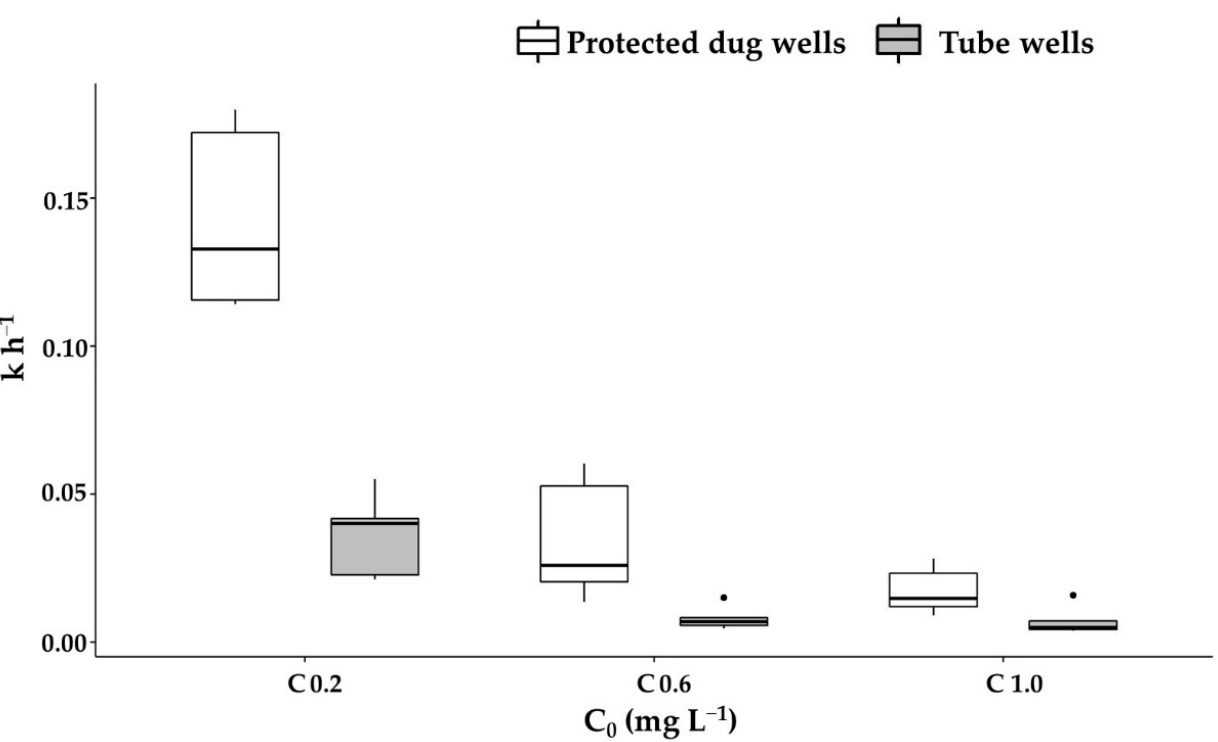
Figure 5. Box-and-whisker plots (min/max, lower/upper quartiles, and median) of analysis of variance of the chlorine decay rate in the water samples from protected dug wells and tube wells in Porto Velho.